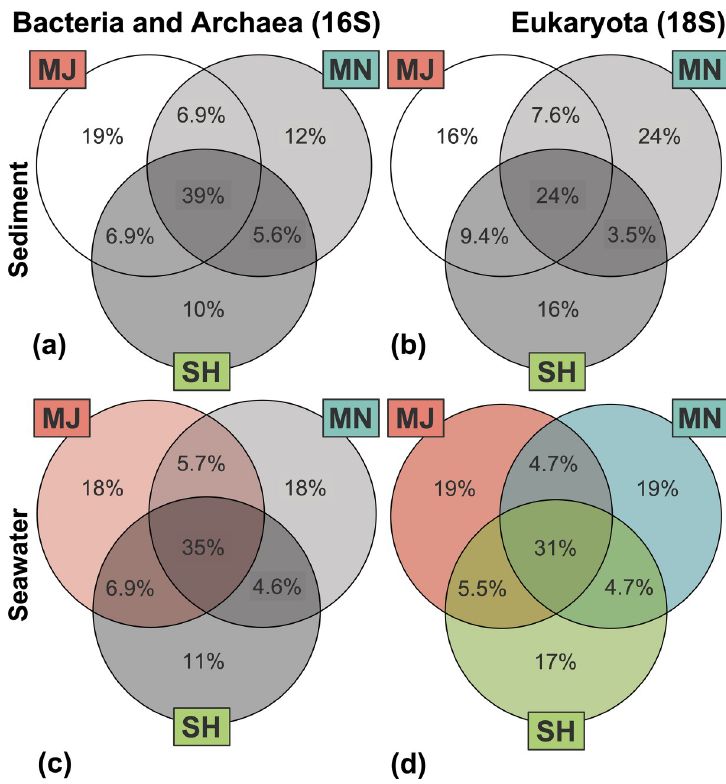
Fig 4. Microbial community composition and beta-diversity. Venn diagrams of percentage overlapping OTUs for bacterial and archaeal as well as eukaryal microbial communities based on richness, with site location colors corresponding to Fig 1. Statistically significant variation by PERMANOVA and pairwise comparison tests is shown in color whereas similarities (no variation) are shown as gray-scale.